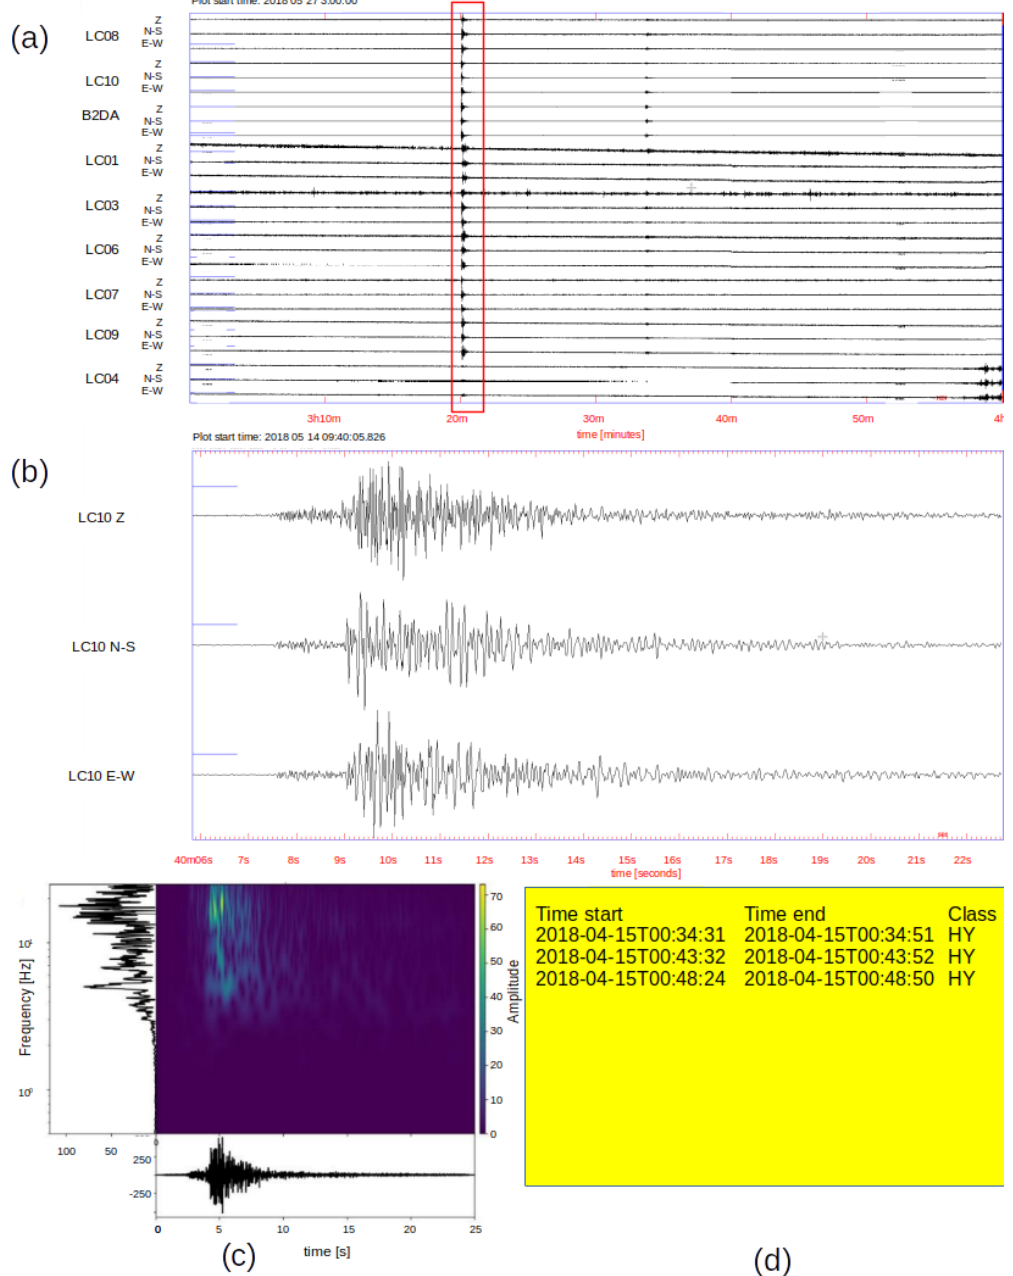
Figure 2. Building Lascar’s database: (a) signal detection, (b) preliminary classification, (c) classification, and (d) signal segmentation.